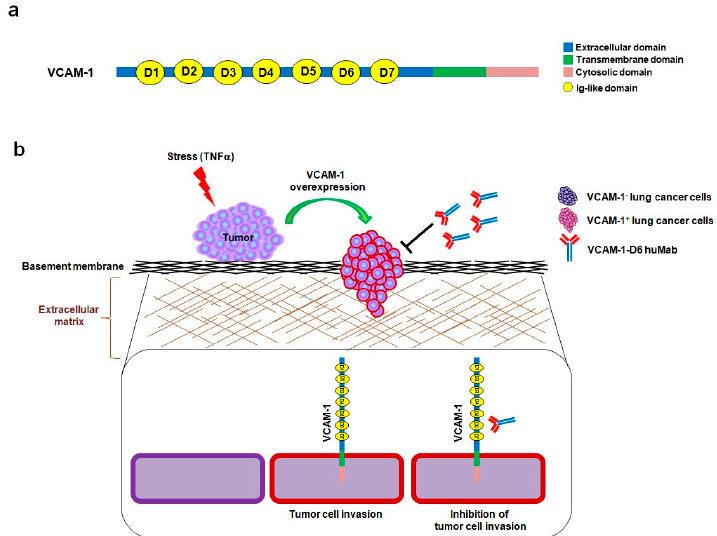
Figure 5. Schematic representation of the inhibitory mechanism of VCAM-1-D6 huMab in lung cancer cell invasion. ( a ) A schematic diagram illustrates the primary structure of VCAM-1, which is comprised of an extracellular domain with seven Ig-like domains (D1~D7), a transmembrane domain, and a cytosolic domain; ( b ) A proposed model of the inhibitory mechanism of VCAM-1-D6 huMab on lung cancer cell invasion is shown. Under stressful conditions, such as the abrupt elevation of TNF α levels within the tumor microenvironment, VCAM-1 levels are dramatically increased on the surface of lung cancer cells. The VCAM-1-D6 domain of VCAM-1 plays a key role in lung cancer cell invasion; however, the addition of VCAM-1-D6 huMab specifically inhibits VCAM-1-mediated lung cancer cell invasion.